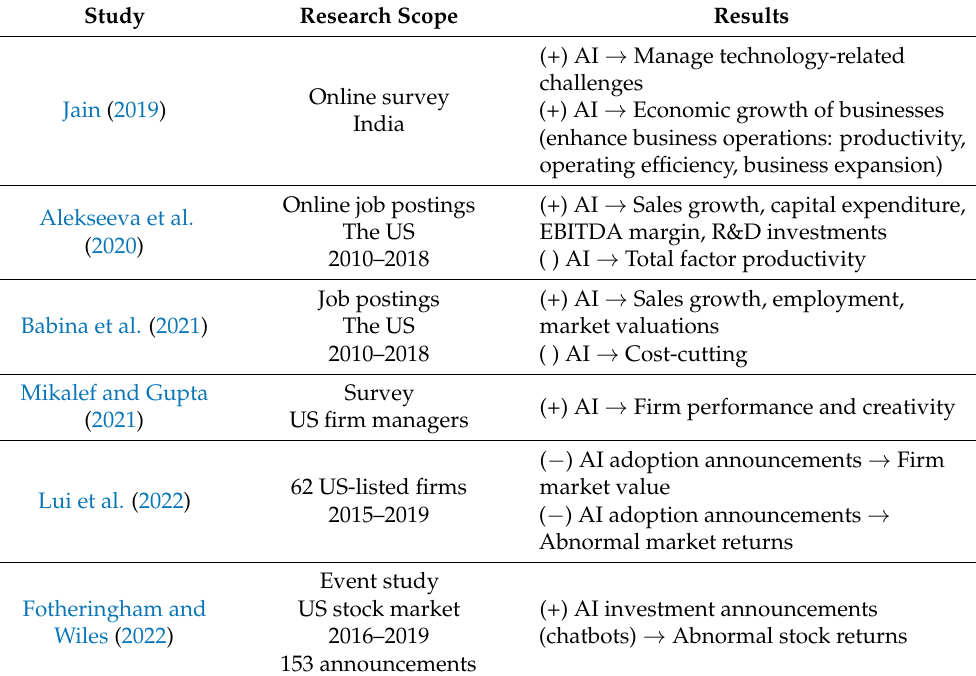
Table 2. Selected empirical studies on Artificial Intelligence adoption and firm